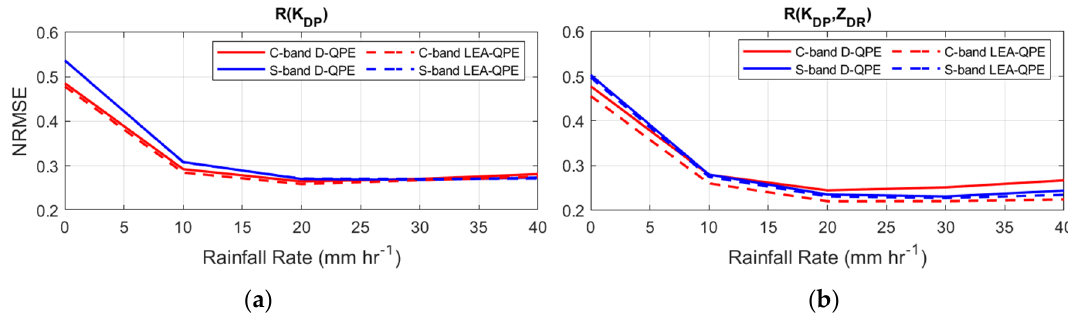
Figure 12. The NRMSE of C-/S-band D-QPE and LEA-QPE from the ( a ) R(K DP ) and ( b ) R(K DP , Z DR ) algorithm.